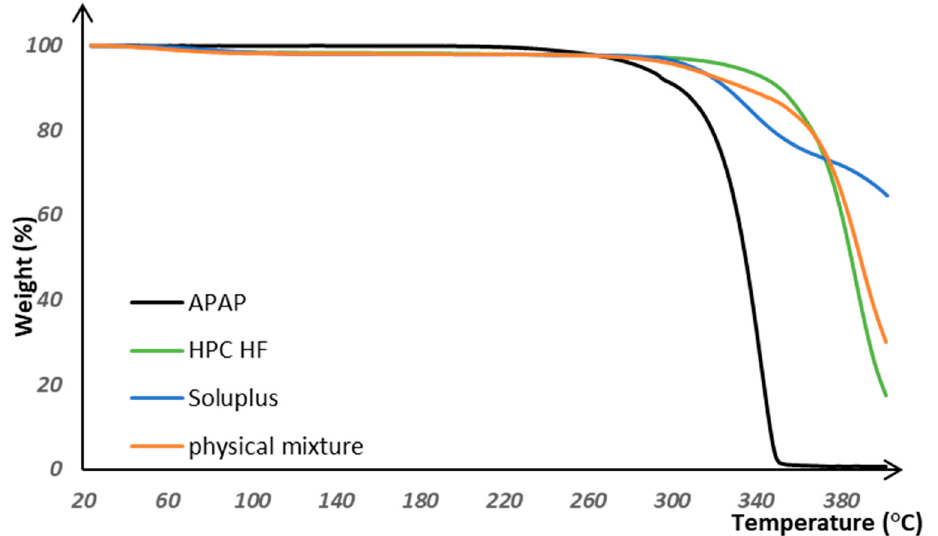
Figure 3. The thermal degradation curves for raw materials and physical mixtures.